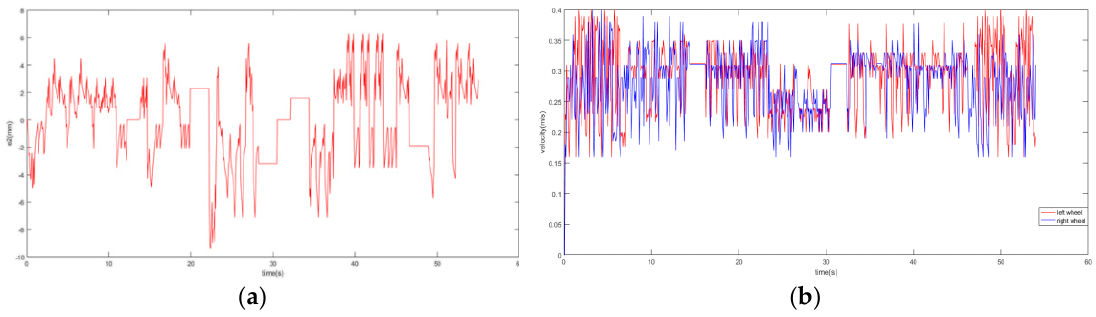
Figure 21. Experimental results that students obtained: ( a ) tracking error, and ( b ) speeds of wheel.